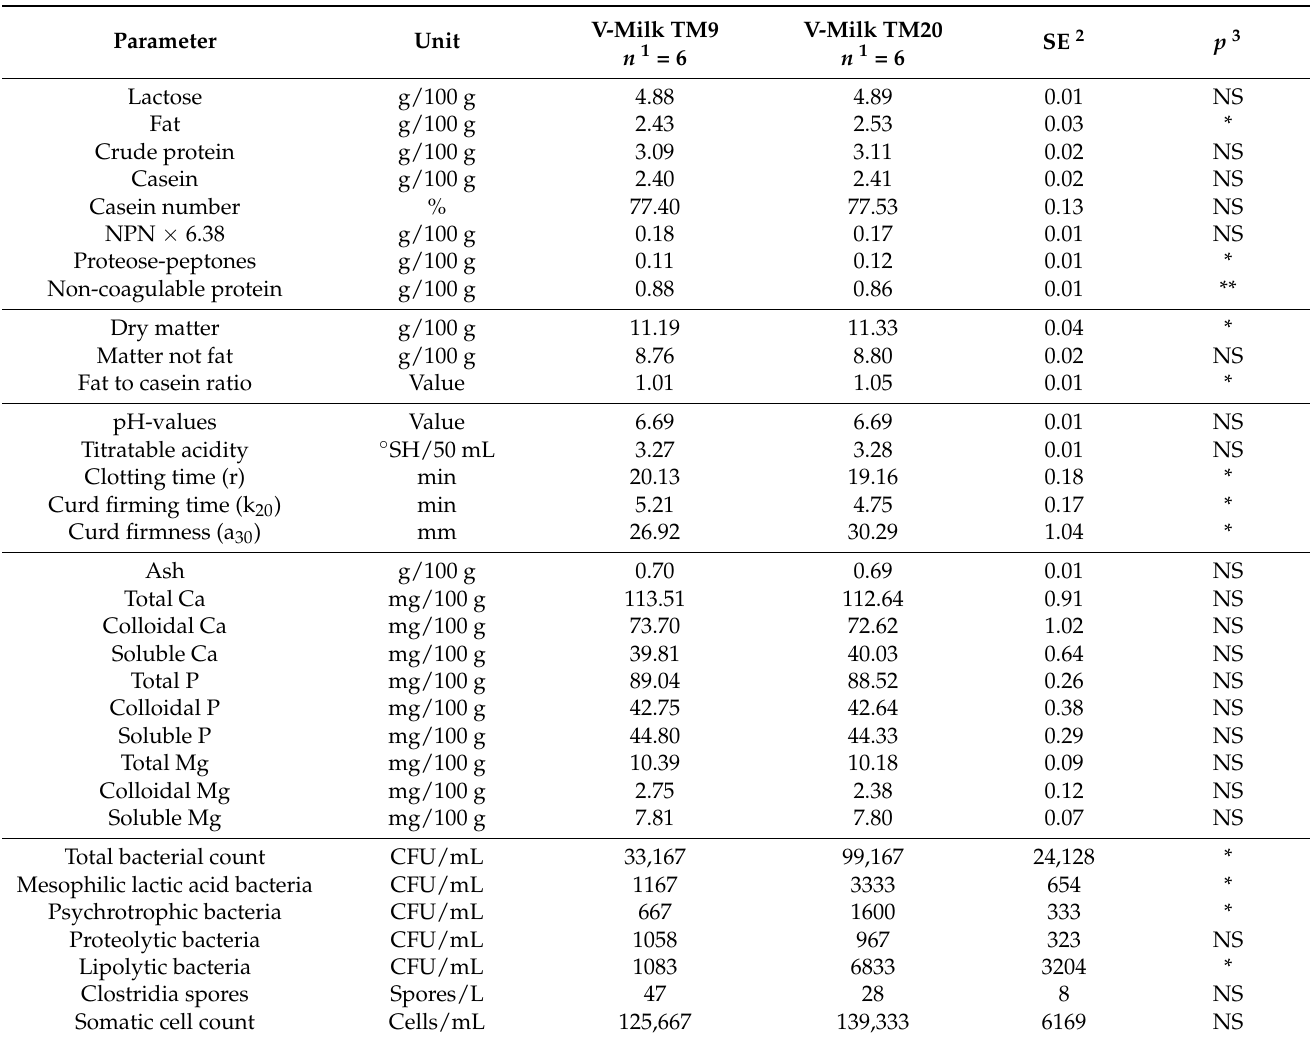
Table 2. Least square mean values of chemical composition, physicochemical properties, and microbiological parameters of the vat milk (V-milk) obtained from the bulk milk kept at the farm at 9 ◦ C (TM9) and at 20 ◦ C (TM20).